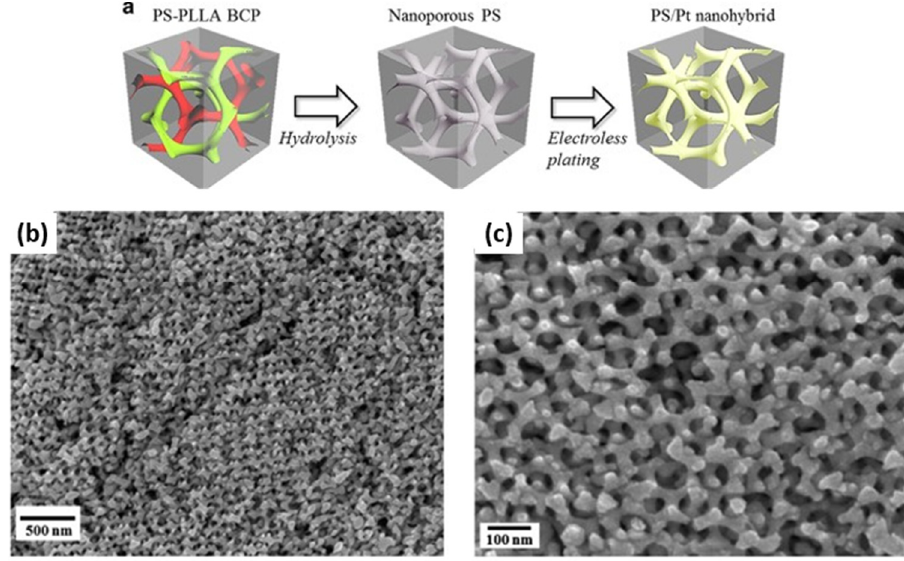
Figure 15. ( a ) Schematic illustration for the fabrication of the PS/Pt gyroid nanohybrids, using a BCP template from the hydrolysis of PS– b –PLLA for electroless plating. ( b , c ) FESEM micrographs of the nanoporous gyroid Pt from the PS/Pt gyroid nanohybrids after removal of the PS templates by UV degradation. Adapted from [45].